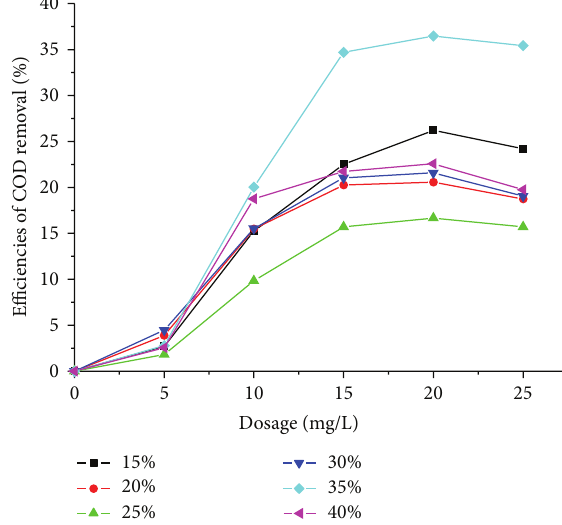
Figure 10: Effects of concentration of monomers on COD removal for